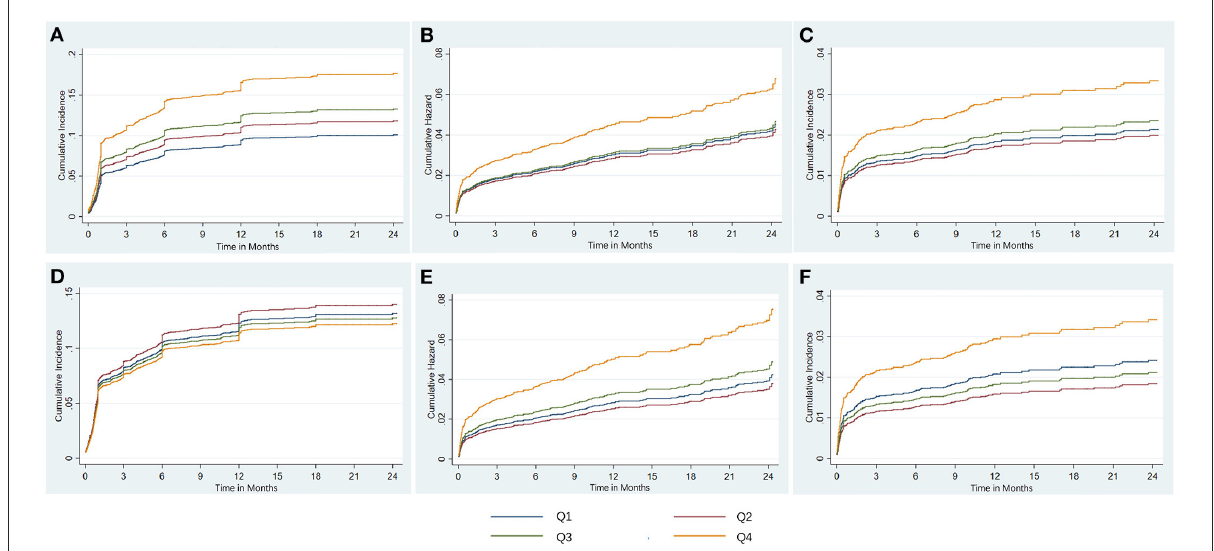
FIGURE4 The risk regression analysis of clinical outcomes based on fully adjusted models. Shown are the cumulative incidence of post discharge HF treating death without HF as competing risk (A) , the cumulative hazard of all-cause death (B) , and the cumulative incidence of cardiac death treating non-cardiac death as competing risk (C) for serum phosphate, and the cumulative incidence of post-discharge HF treating death without HF as competing risk (D) , the cumulative hazard of all-cause death (E) , and the cumulative incidence of cardiac death treating non-cardiac death as competing risk (F) for corrected serum calcium. HF, heart failure; Q,